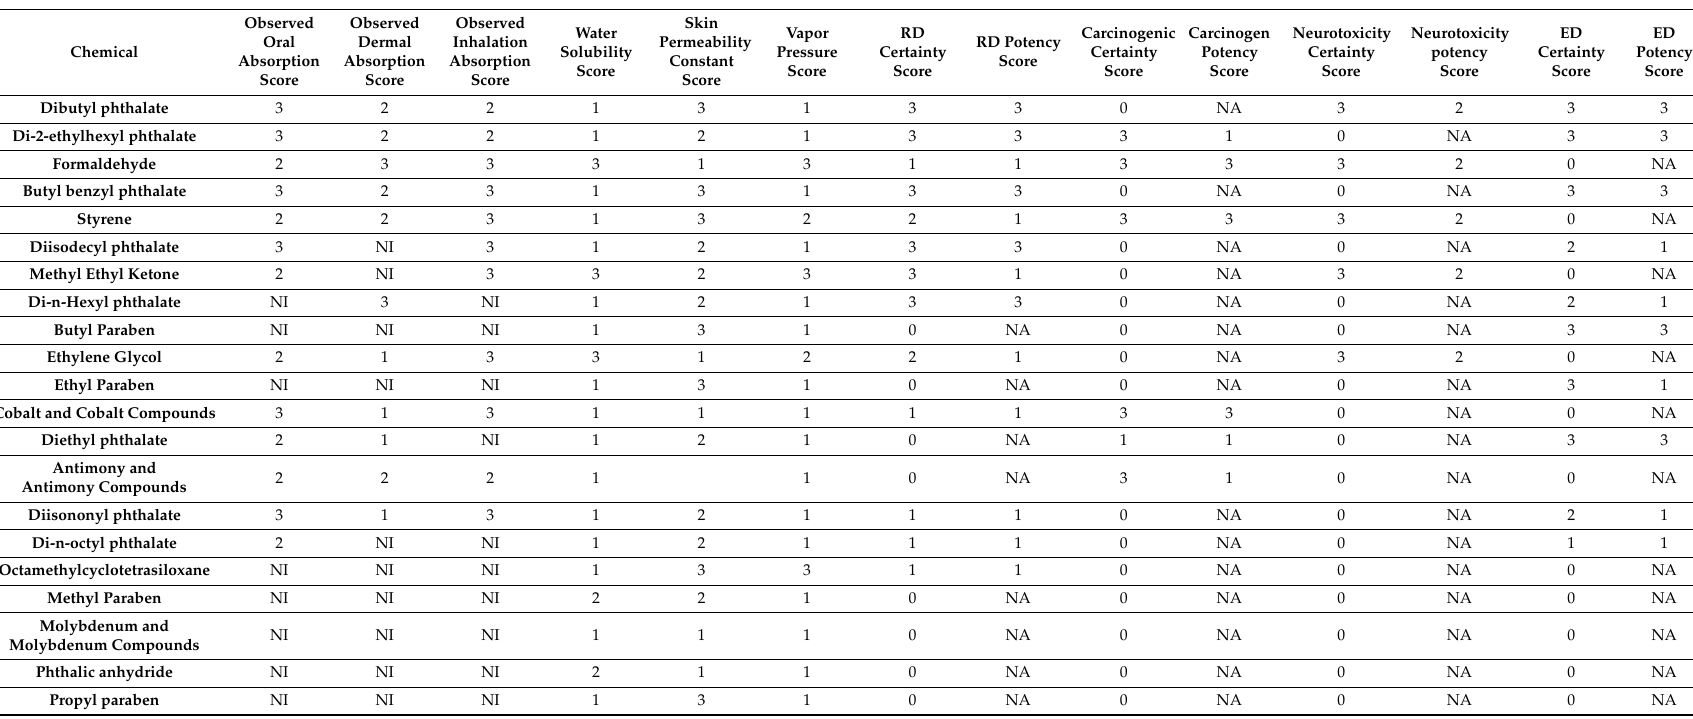
Table 2. Scores assigned to each chemical based on the approach described in the text. Chemicals are sorted based on the highest total priority index. Rationale and criteria for the scores are shown in Table